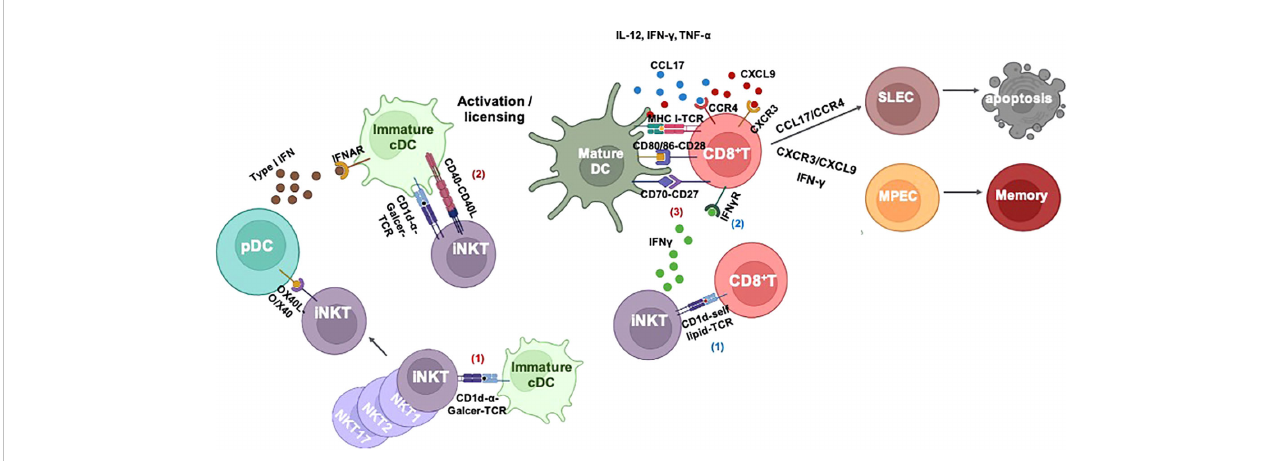
FIGURE 2 iNKT cell-mediated CD8 + T-cell immunity. I) iNKT cell-mediated cross-priming of CD8 + T cells after responding to a -Galcer: 1) iNKT cells are activated by a -Galcer without any costimulatory signals. 2) Immature DCs capture antigens and interact with activated iNKT cells to undergo iNKT cell-induced maturation via CD40 – CD40L and in fl ammatory cytokine IFN- g and TNF- a . Activated iNKT cells can also activate plasmacytoid DC (pDC) via OX40L – OX40 signaling; thereafter, pDC assists DC maturation and cross-priming of CD8 + T cells in a type I IFN-dependent manner. iNKT cell-mediated DC licensing promotes DC cross-presentation of antigens to CD8 + T cells via upregulation of costimulatory signals such as CD80/86 – CD28, CD70 – CD27, and cytokines IL-12, IFN- g , and TNF- a . II) Without exogenous lipid antigen: iNKT cells can be activated by CD8 + T cells through CD1d – self lipid – TCR engagement. Activated iNKT cells enhance CD8 + T-cell effector function in an IFN- g dependent manner. III) iNKT cell-mediated CD8 + T-cell fate decision: 1) iNKT cell-mediated cross-talk of pDC – cDC – CD8 + T cells promotes memory CD8 + T-cell development. 2) iNKT-mediated cDC licensing SLEC development via CCL17/CCR4 or MPEC development via CXCR3/CXCL9 and IFN- g . iNKT, invariant natural killer T; DCs, dendritic cells; TCR, T-cell receptor; SLEC, short-lived effector cell; MPEC, memory precursor effector